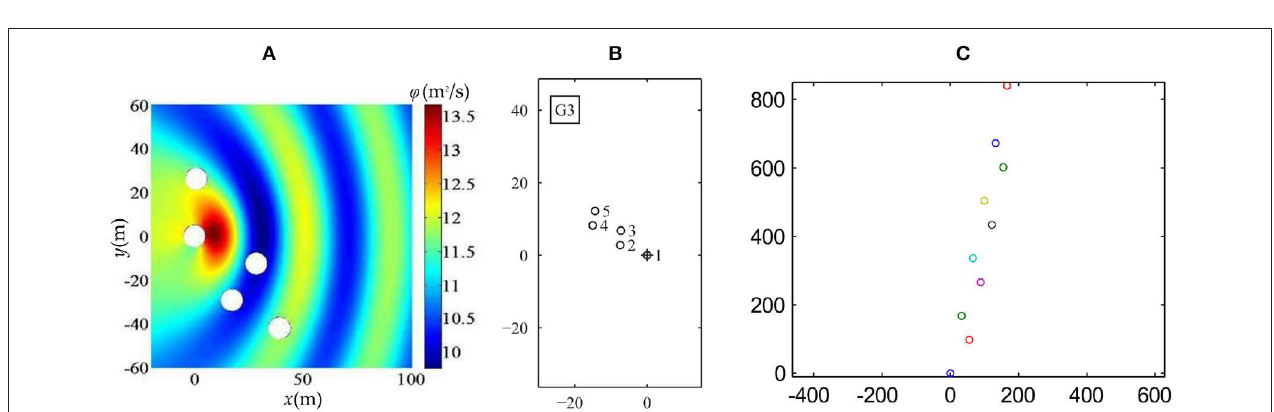
FIGURE 13 | (A) Optimal five-WEC array layout obtained by Fang et al. (2018) with an evolutionary algorithm and regular waves. (B) Optimal layout of five WECs in regular waves by a GA optimization (Child and Venugopal, 2010). (C) Optimal layout of 10 WECs in irregular waves propagating along the x -direction, obtained with the array design tool in WaveFarmer (Child et al.,